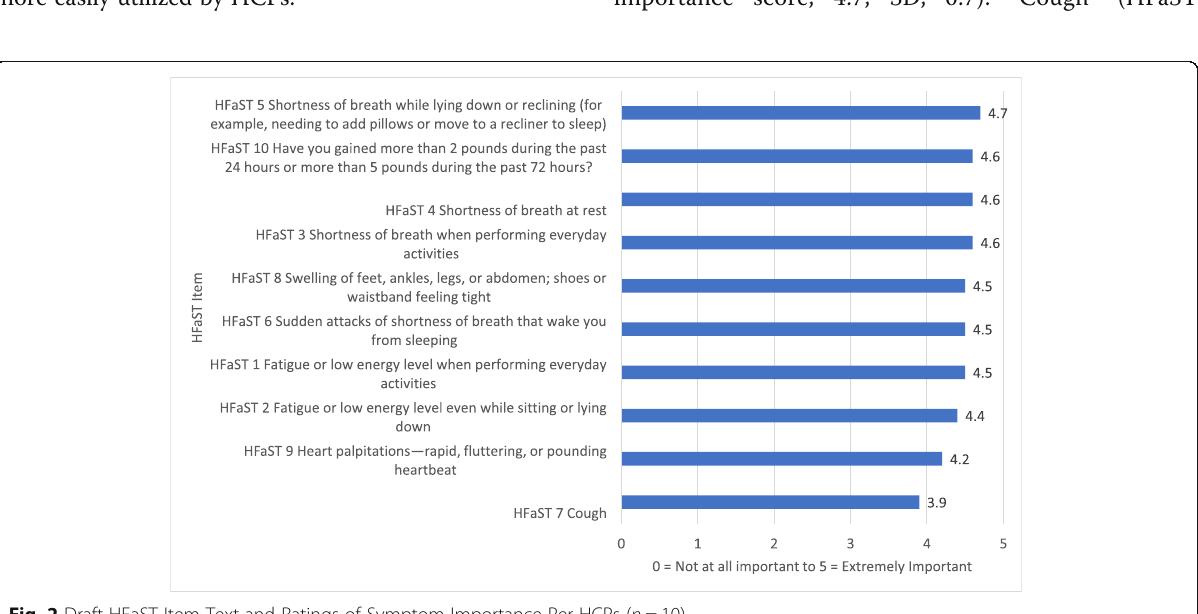
file 1: Table S10). On average, HCPs rated “ shortness of breath while lying down or reclining ” (HFaST Item 5) as the most important HFaST item (mean importance score, 4.7; SD, 0.7). “ Cough ” (HFaST